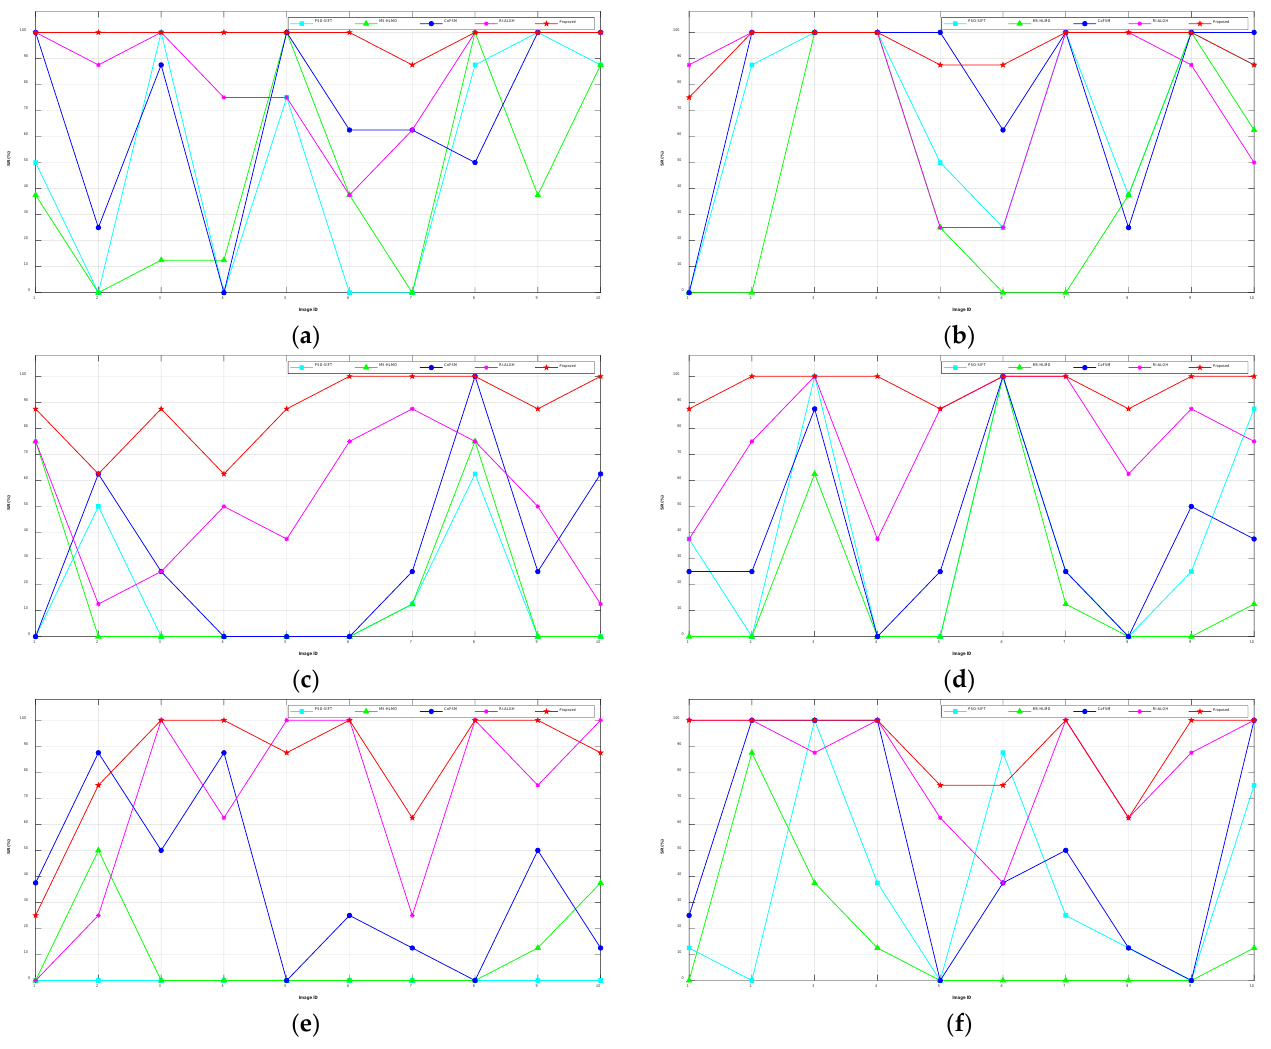
Figure 7. Comparative results for the SR metric: ( a ) optical–optical; ( b ) optical–infrared; ( c ) optical– depth; ( d ) optical–map; ( e ) optical–SAR; and ( f ) day–night. Table 5. Quantitative evaluation results for each